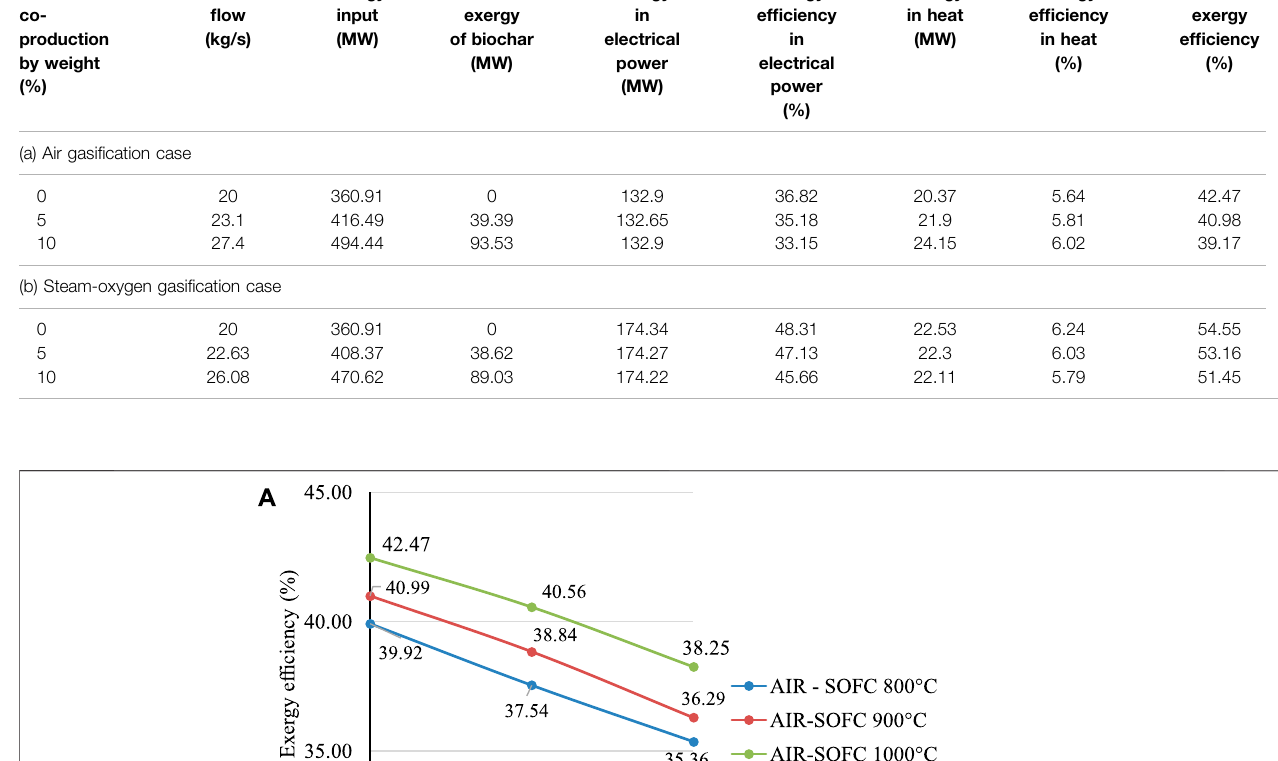
TABLE 11 | Effect of biochar co-production for the given electrical power output in each gasi fi cation case. Biochar co- production by weight